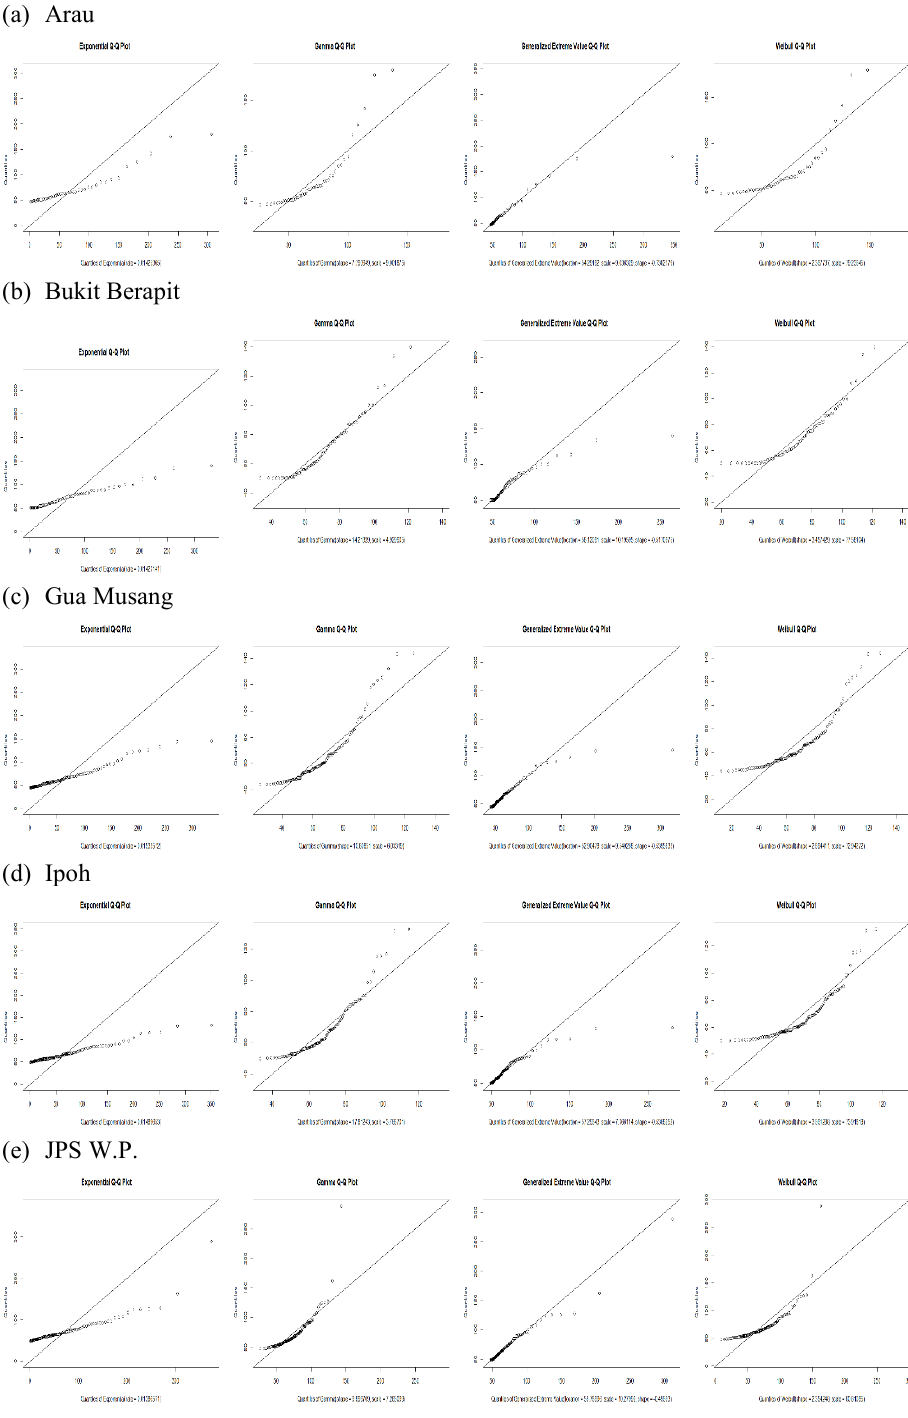
Fig. 3. Q - Q plots for selected rainfall station with threshold of 95 th